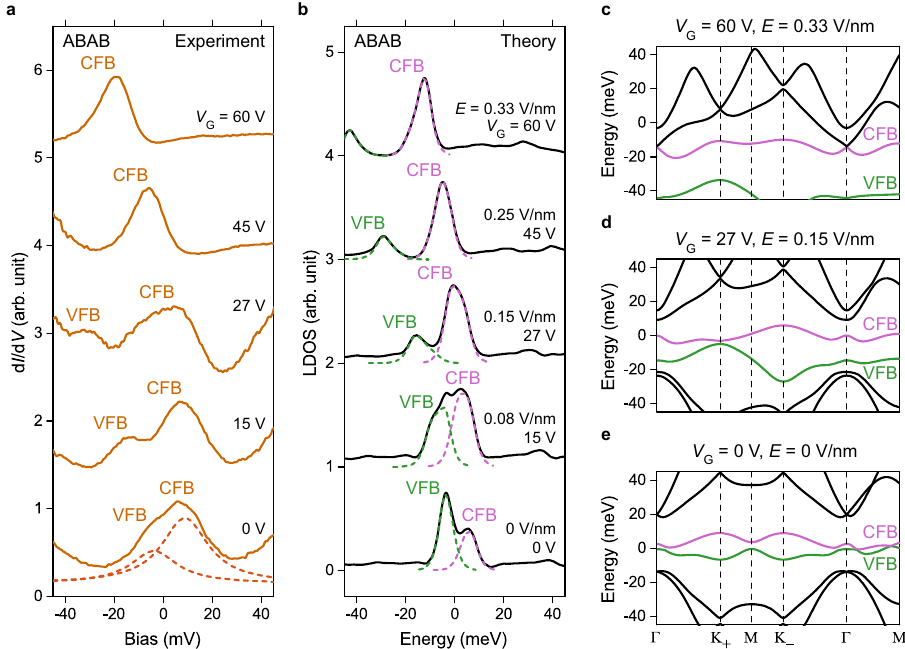
Fig. 2 Electric fi eld tuning of tDBLG electronic structure. a d I /d V spectra measured in an ABAB region under different back-gate voltages (modulation voltage V RMS = 1 mV; initial V Bias = – 100 mV, I 0 = 0.5 nA). b Theoretical LDOS for ABAB region for gate voltages in a (corresponding E - fi eld values are shown). The dashed curves denote contributions from each separate fl at band. c – e Single-particle band structure along the high symmetry directions of the tDBLG moiré Brillouin zone for c V G = 0, E = 0; d V G = 27 V, E = 0.15 V/nm; and e V G = 60 V, E = 0.33 V/nm. For clarity only bands from a single valley are shown. CFB conduction fl at band, VFB valence fl at